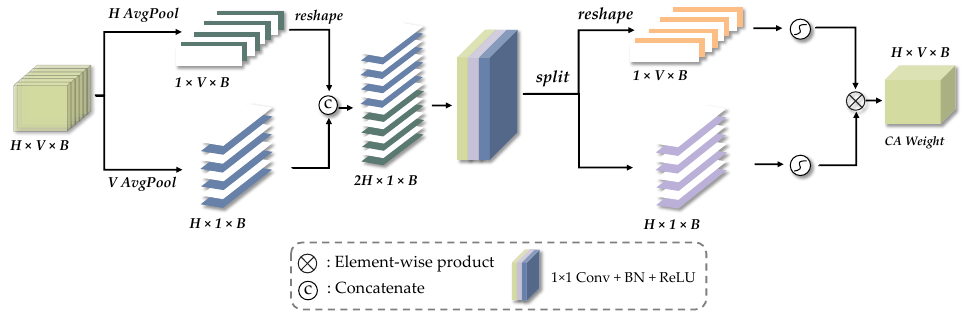
Figure 3. The proposed BSAM